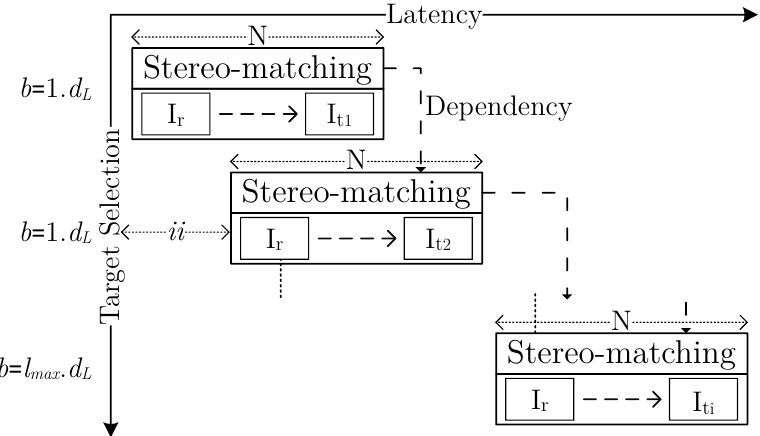
Figure 10. Selection process of target micro-images entailing temporal parallelism.